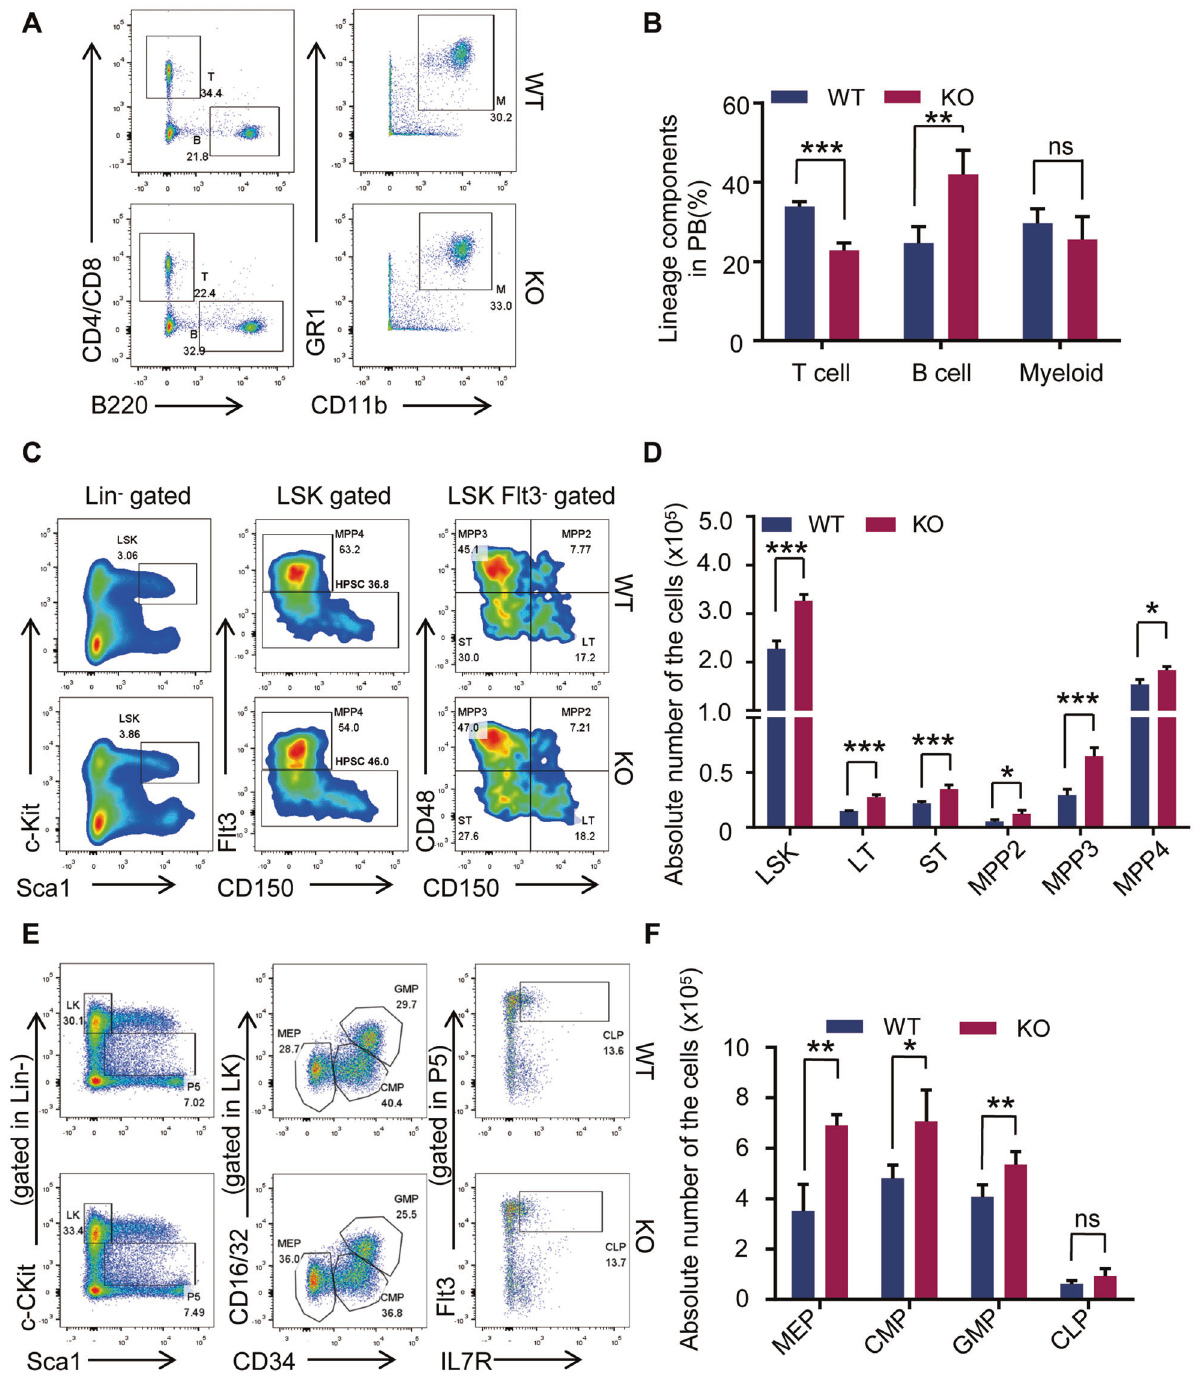
Fig. 3 Eva1a de fi ciency increases the number of HSPCs. A, B Representative FACS plots ( A ) and Quanti fi cation of the composition ( B ) of T (CD4 + /CD8 + ) cells, B (B220 + ) cells, and myeloid (GR1 + CD11b + ) in PB from WT and Eva1a F / F,Vav-Cre mice ( n = 5). C, D Representative FACS plots ( C ) and quanti fi cation of the absolute number ( D ) of LSK (Lin − cKit + Sca1 + ) cells, LT-HSC (Lin − cKit + Sca1 + Flt3 − CD150 + CD48 − ) cells, ST-HSC (Lin − cKit + Sca1 + Flt3 − CD150 − CD48 − ) cells, MPP4 (Lin − cKit + Sca1 + Flt3 + ) cells, MPP3 (Lin − cKit + Sca1 + Flt3 − CD48 + CD150 − ) cells and MPP2 (Lin − cKit + Sca1 + Flt3 − CD48 + CD150 + ) cells in WT and Eva1a F/F,Vav-Cre mice ( n = 5). E, F Representative FACS plots ( E ) and quanti fi cation of the absolute presented as mean ± SD, (* p < 0.05, * *p < 0.01, and *** p < TIM23 between WT and Eva1a de fi cient Lin − BM cells, even after 5FU treatment and transplantation (Fig. S4B, D, F). Taken together, these data suggest that Eva1a deletion does not affect HSPCs autophagy.